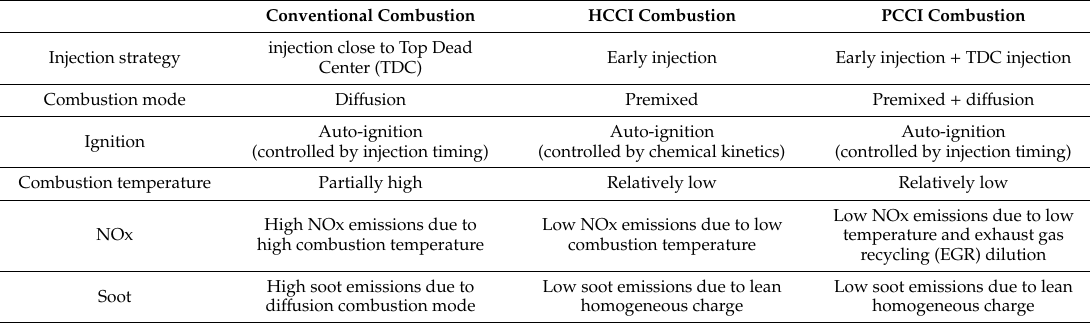
Table 1. Comparison of key characteristics of conventional diesel, HCCI, and PCCI combustion.